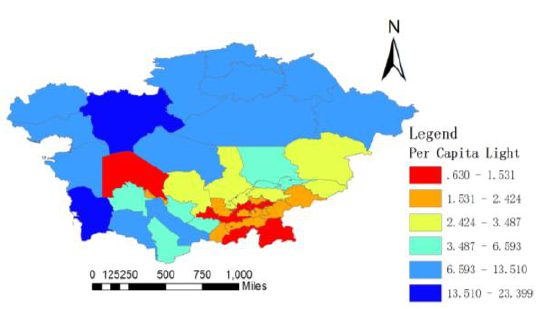
Figure 11. The distribution of per capita lighting In terms of the distribution of per capita lighting, the areas with low values are concentrated in the southeastern region, including Tajikistan, southern Kyrgyzstan, and northwestern, southern, and central Uzbekistan. A comparison of the GDP of the five Central Asian countries and per capita nighttime lights showed that areas with little per capita lighting were the poor areas, confirming that the total amount of nighttime lights reflects the pattern of uneven development and poor areas, to a certain extent.